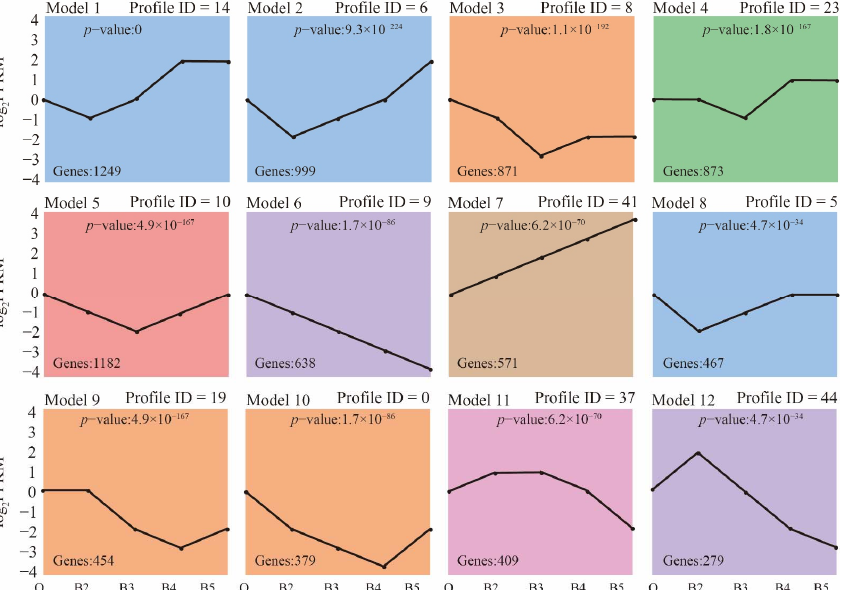
Figure 3. Series test of cluster (STC) analysis of DEGs during postembryonic development. The DEGs clustered into 12 major groups, based on patterns of gene expression during the five developmental stages using the STEM clustering method. The black line shows the average log 2 FPKM to visualize the expression trend of each cluster. The same color indicates similar gene expression patterns. The X axis shows the five developmental stages. O: hatched first instar larvae, B2: second instar larvae, B3: third instar larvae, B4: wandering larvae and B5: pupae.